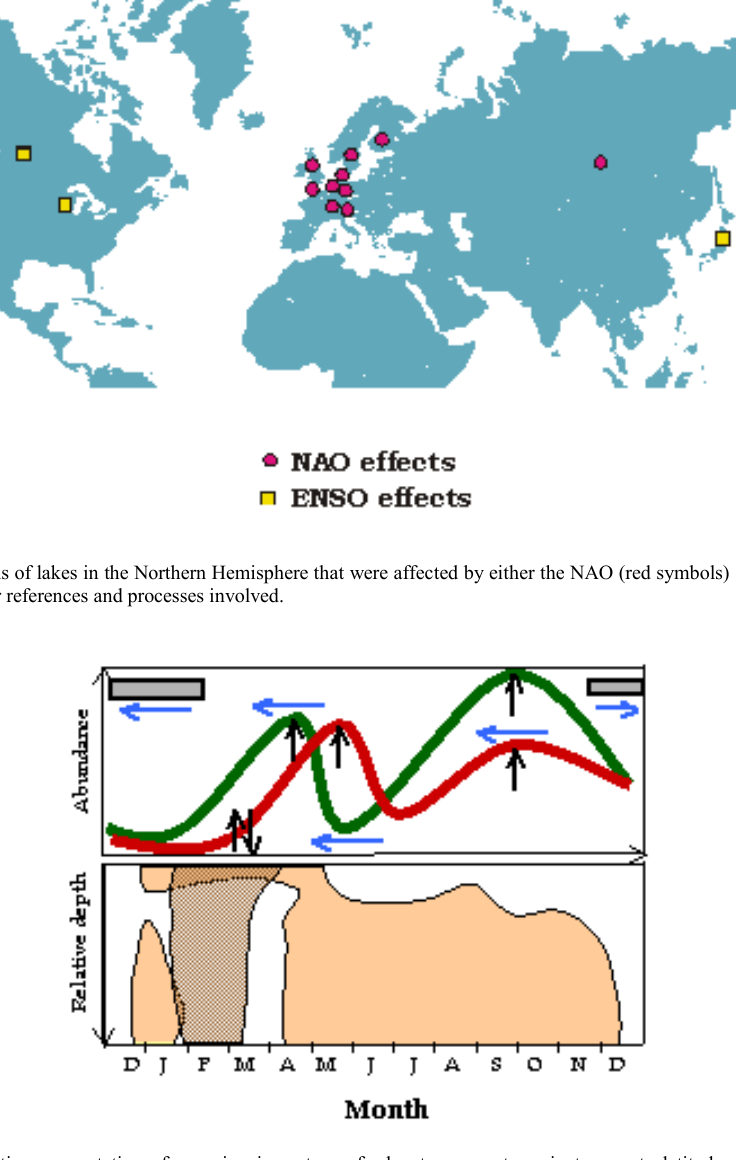
FIGURE 2. Schematic representation of warming impacts on freshwater ecosystems in temperate latitudes, based on long-term observations for a variety of lakes in Europe (see text for references). The upper panel illustrates effects on the seasonal plankton phenology in meso- and eutrophic lakes (green line, phytoplankton; red line, zooplankton; modified PEG-model[94]), and on the ice phenology (gray bar). Black arrows denote either increasing ( ↑↑↑↑ ) or decreasing ( ↓↓↓↓ ) abundance of plankton species or groups. Blue arrows indicate changes toward earlier ( ←←←← ) or later dates ( →→→→ ) of succession events. The lower panel indicates significant correlations ( p < 0.05) between the winter NAO index and water temperature profiles of both a shallow polymictic (brown area) and a deep dimictic lake (orange area) (modified after Gerten and Adrian 2001[32]). Note that ENSO impacts on water temperature are likely to vary in a similar manner among lake